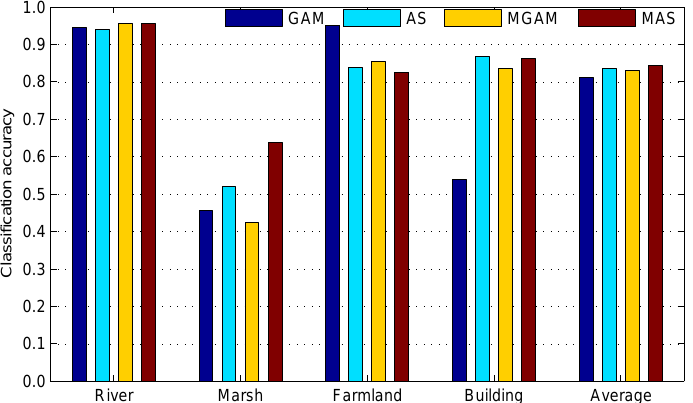
Figure 8. Classification accuracies of different classifiers on Wuhan dataset.